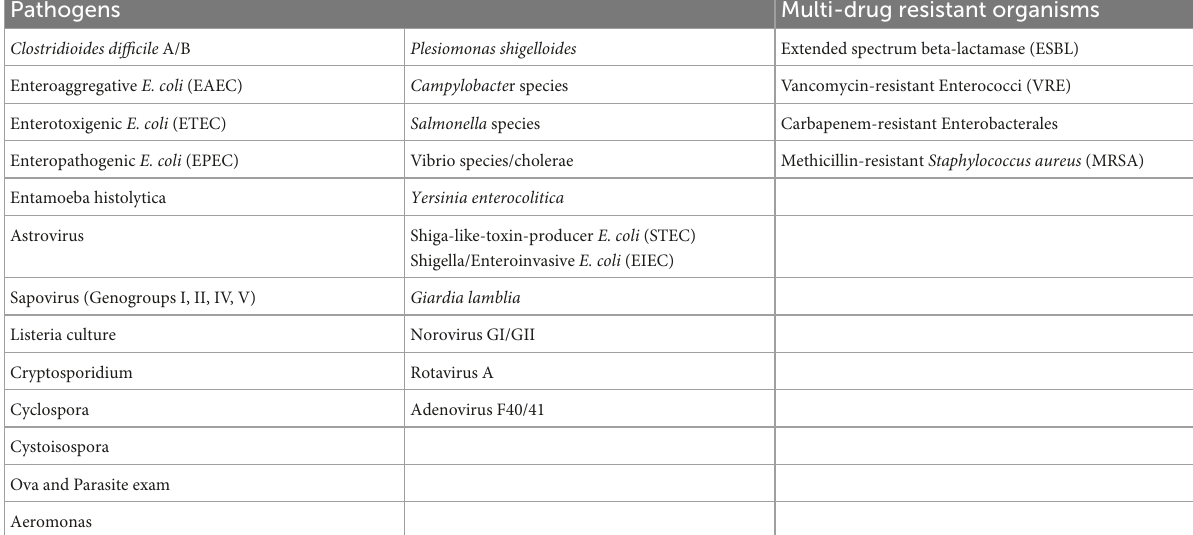
TABLE 1 Pathogen screening on RBX2660.